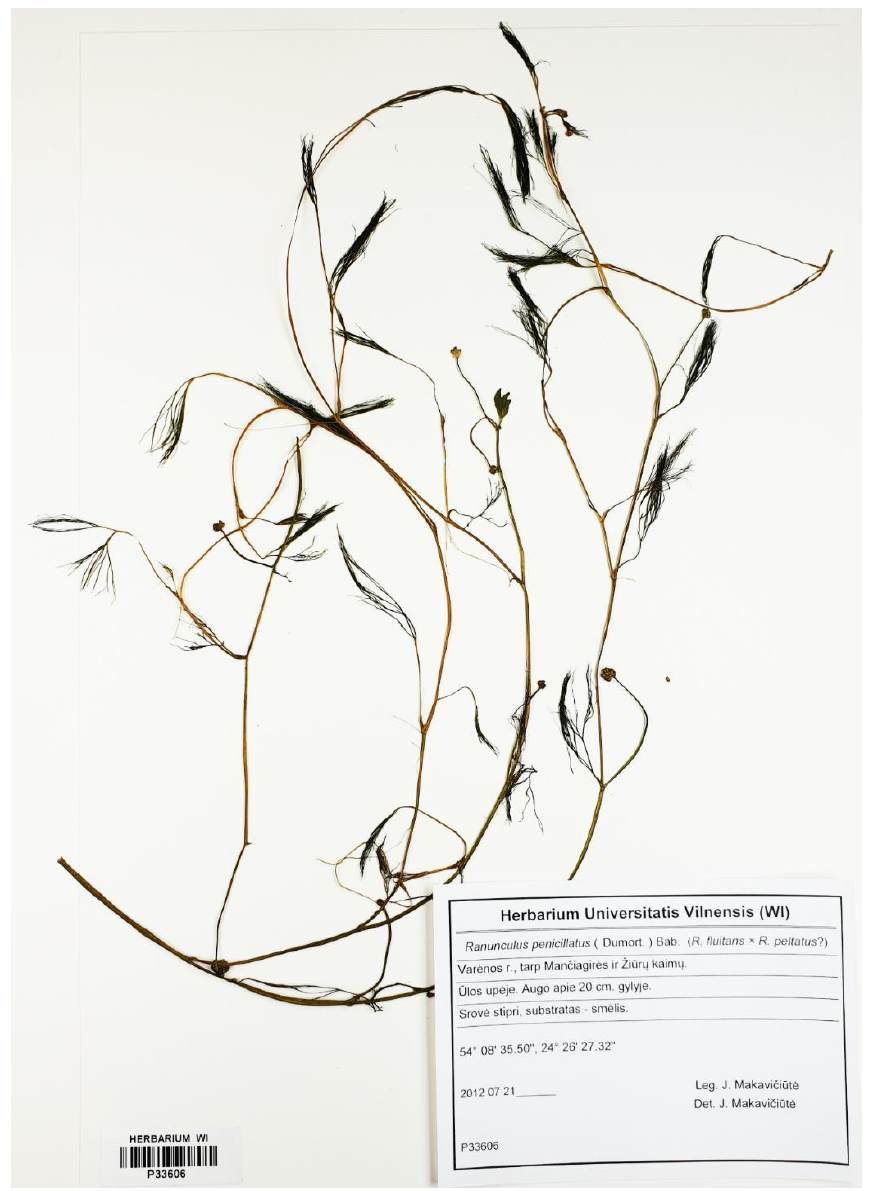
Figure 4. General appearance of putative Ranunculus penicillatus s.l. plant with capillary leaves and intermediate leaves from the Ula River.